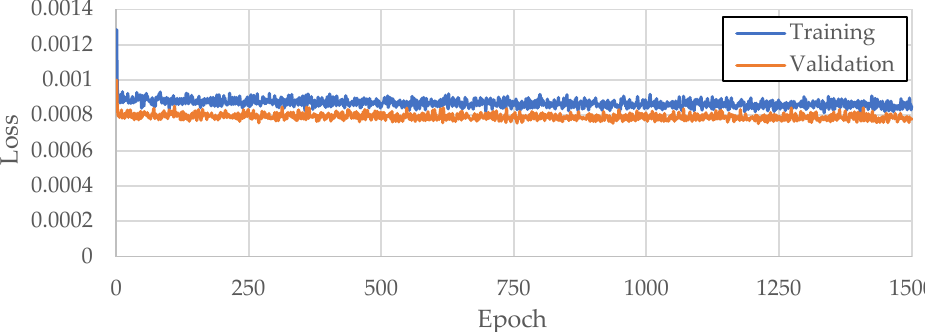
Figure 20. Training and validation losses produced in Model 2 over 1500 epochs.